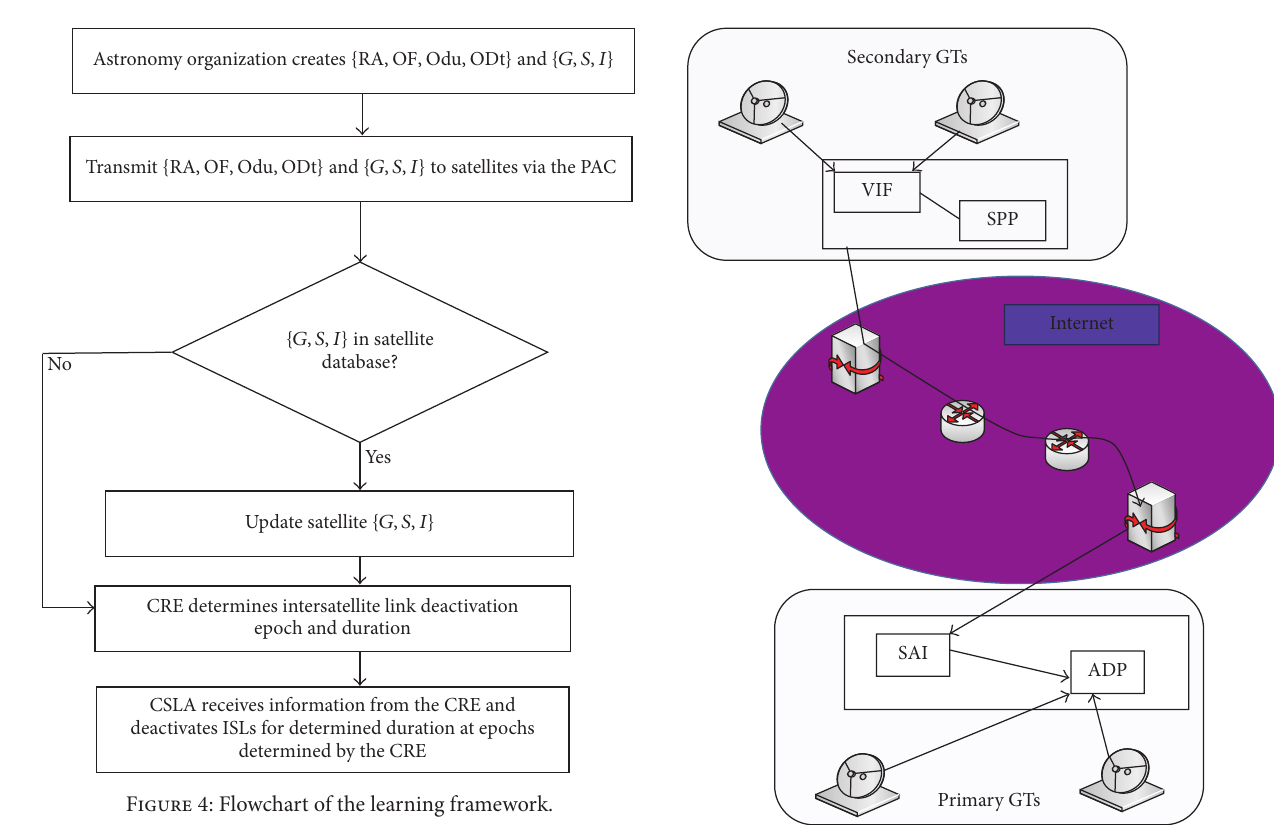
Figure 5: Interaction between primary and secondary